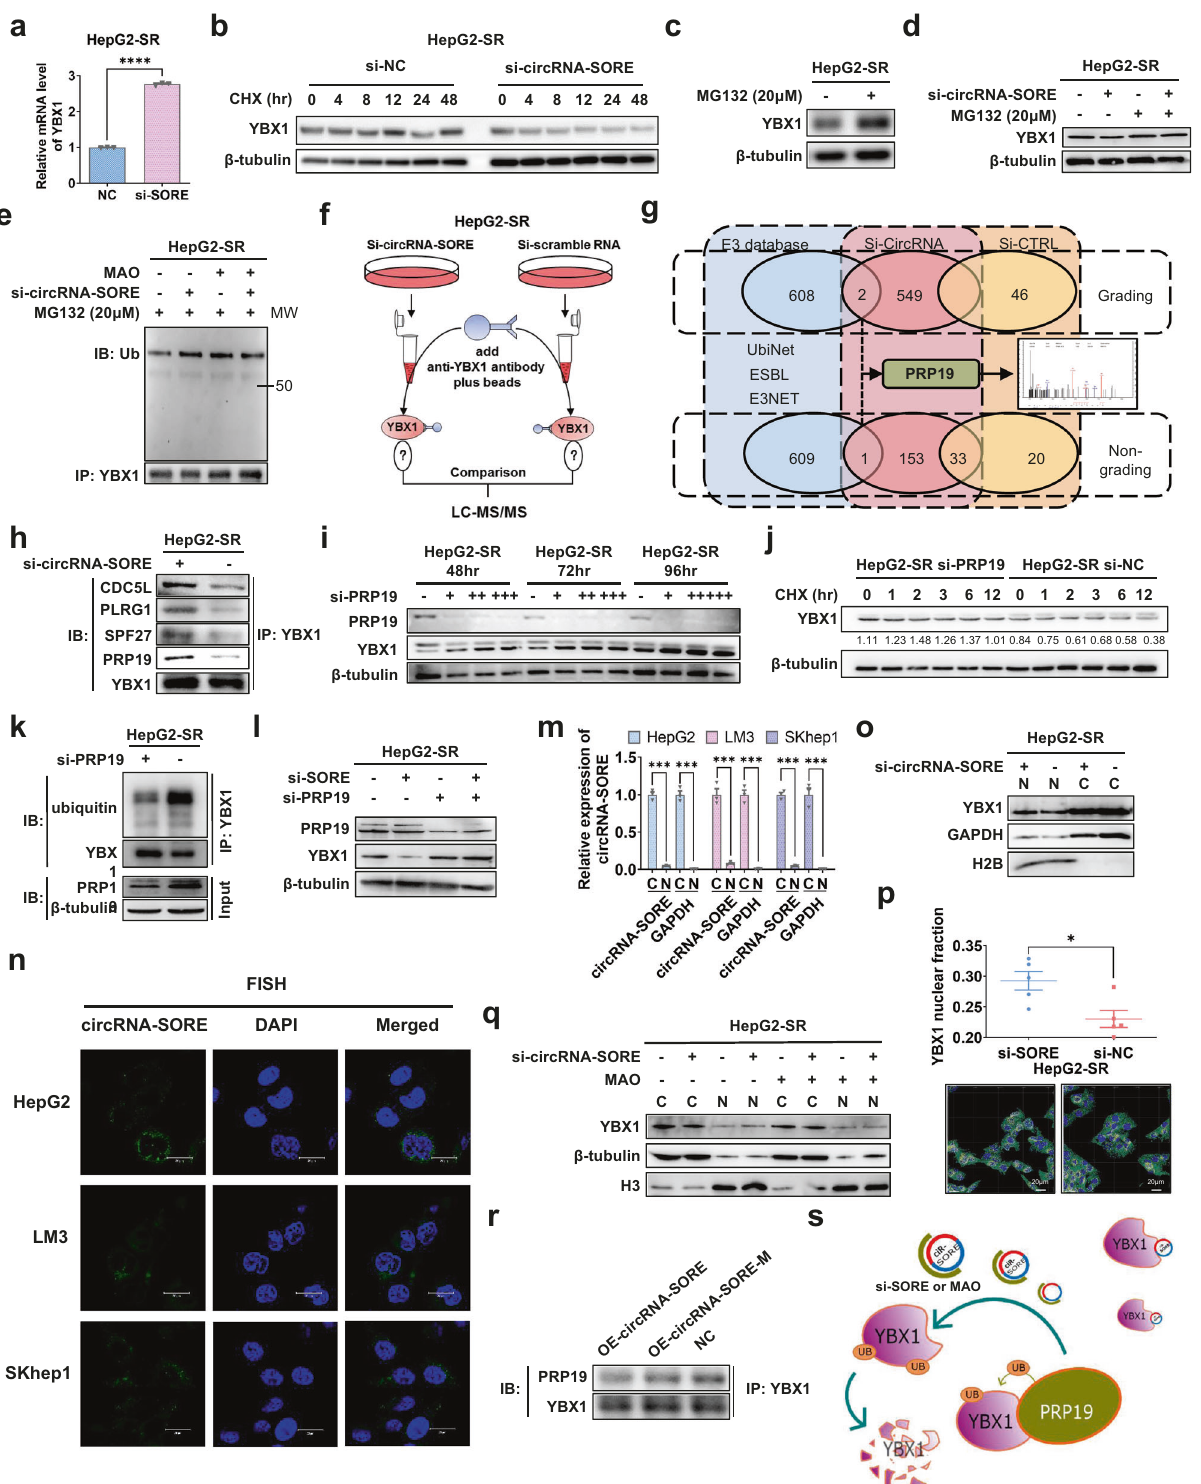
limited and show low ef fi cacy. 27,28 As the fi rst FDA-approved molecular-targeted drug, sorafenib provided a 3-month prolonga- tion of the median OS time according to The Sorafenib HCC Assessment Randomized Protocol (SHARP) trial 29 and the Phase III Sorafenib Asia-Paci fi c (AP) trial. 2 However, sorafenib resistance, which often develops within 6 months, has caused